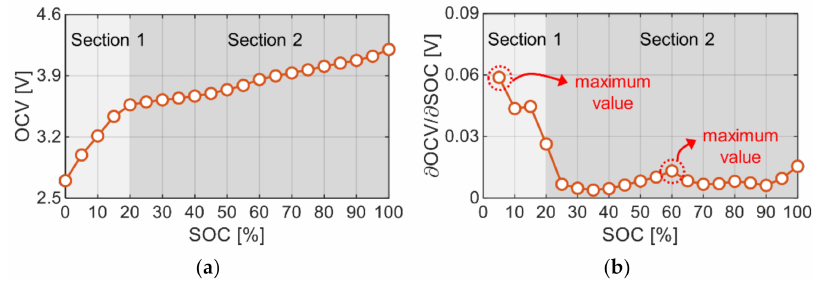
Figure 3. Look-up tables for calculating (2): ( a ) SOC-to-OCV; ( b ) SOC-to- ∂ OCV/ ∂